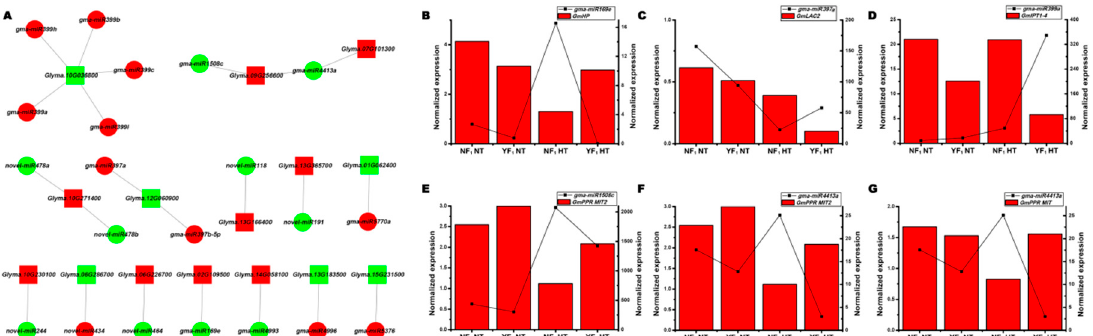
Figure 4. Regulatory network of miRNA-target in the flower bud of soybean CMS-based F 1 under HT stress. ( A ) Regulatory network of miRNA-target under HT condition. Red/green circle/box indicates up or downregulated miRNA/target, respectively. ( B – G ) Expression levels of HT-responsive miRNAs and their targets in the flower bud of soybean CMS-based F 1 under HT stress. The right and left y -axes are the normalized expression level scales for miRNA and its target, respectively.